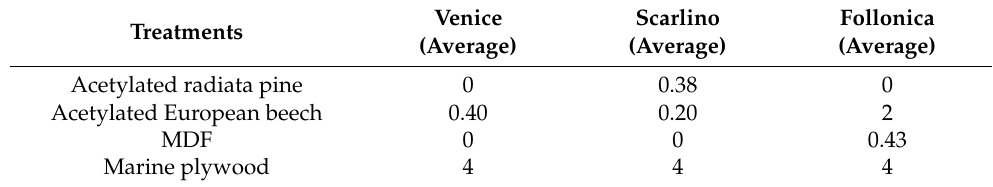
Table 4. Results expressed as nominal value in accordance with EN